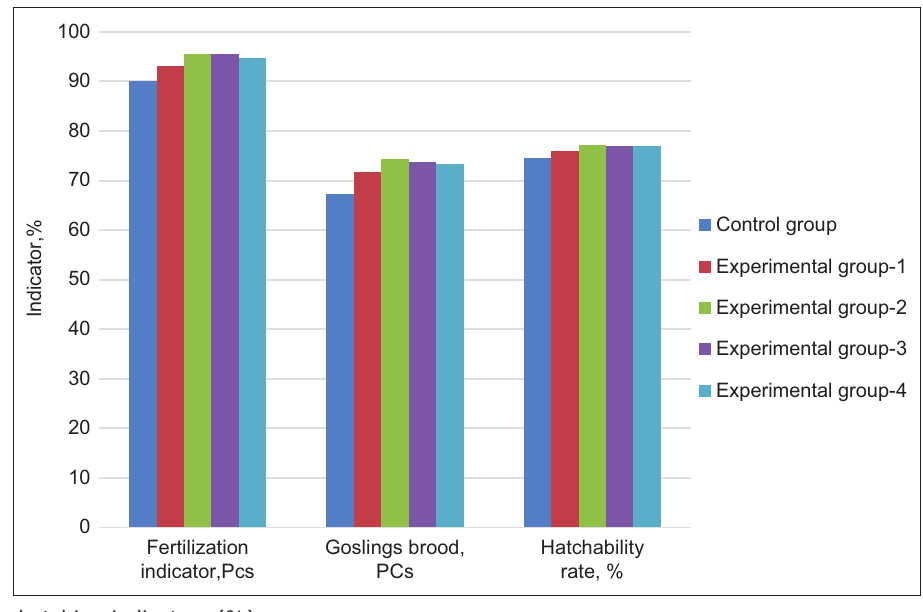
Figure-3: Eggs hatching indicators Table-1: Use of feed nutrients in the diet (%). Indicator